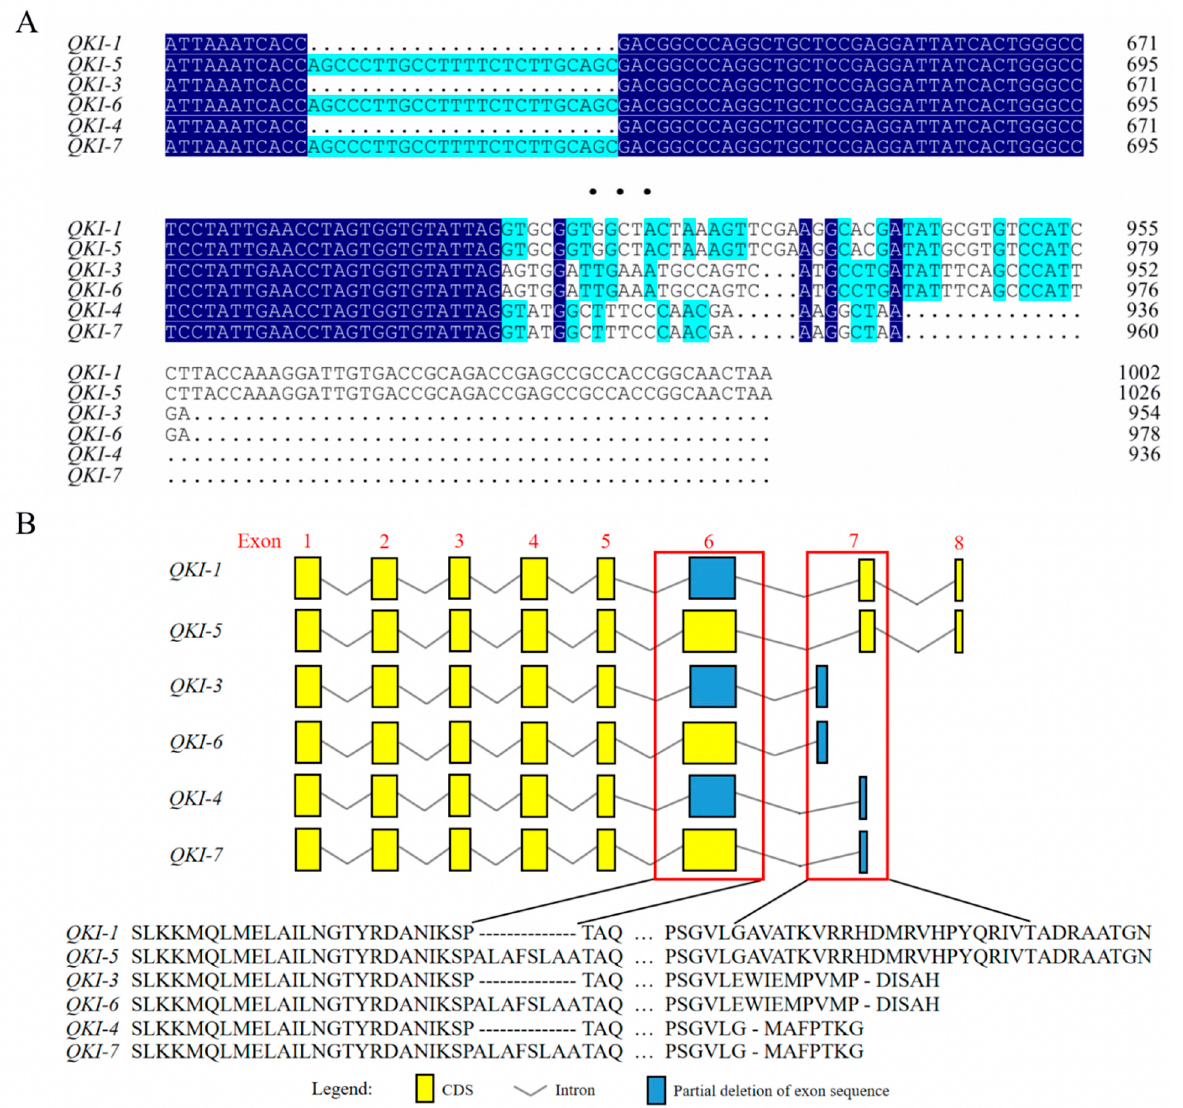
Figure 1. ( A ) Alignment of the amino-acid sequences on the different parts of the QKI isoforms. ( B ) Alternative splicing analysis of the QKI isoforms. Yellow rectangles indicate exons. Blue rectangles indicate partial deletion of exon sequences. Broken lines indicate introns. Red boxes indicate exon sites with possible alternative splicing.